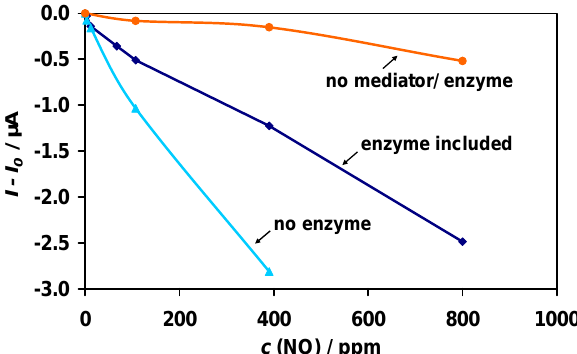
Figure 10. Cross-sensitivity of the enzymatic biosensor to NO (0 - 800 vppm). Components like the enzyme formaldehyde dehydrogenase, NAD + , and the mediator PT were omitted step by